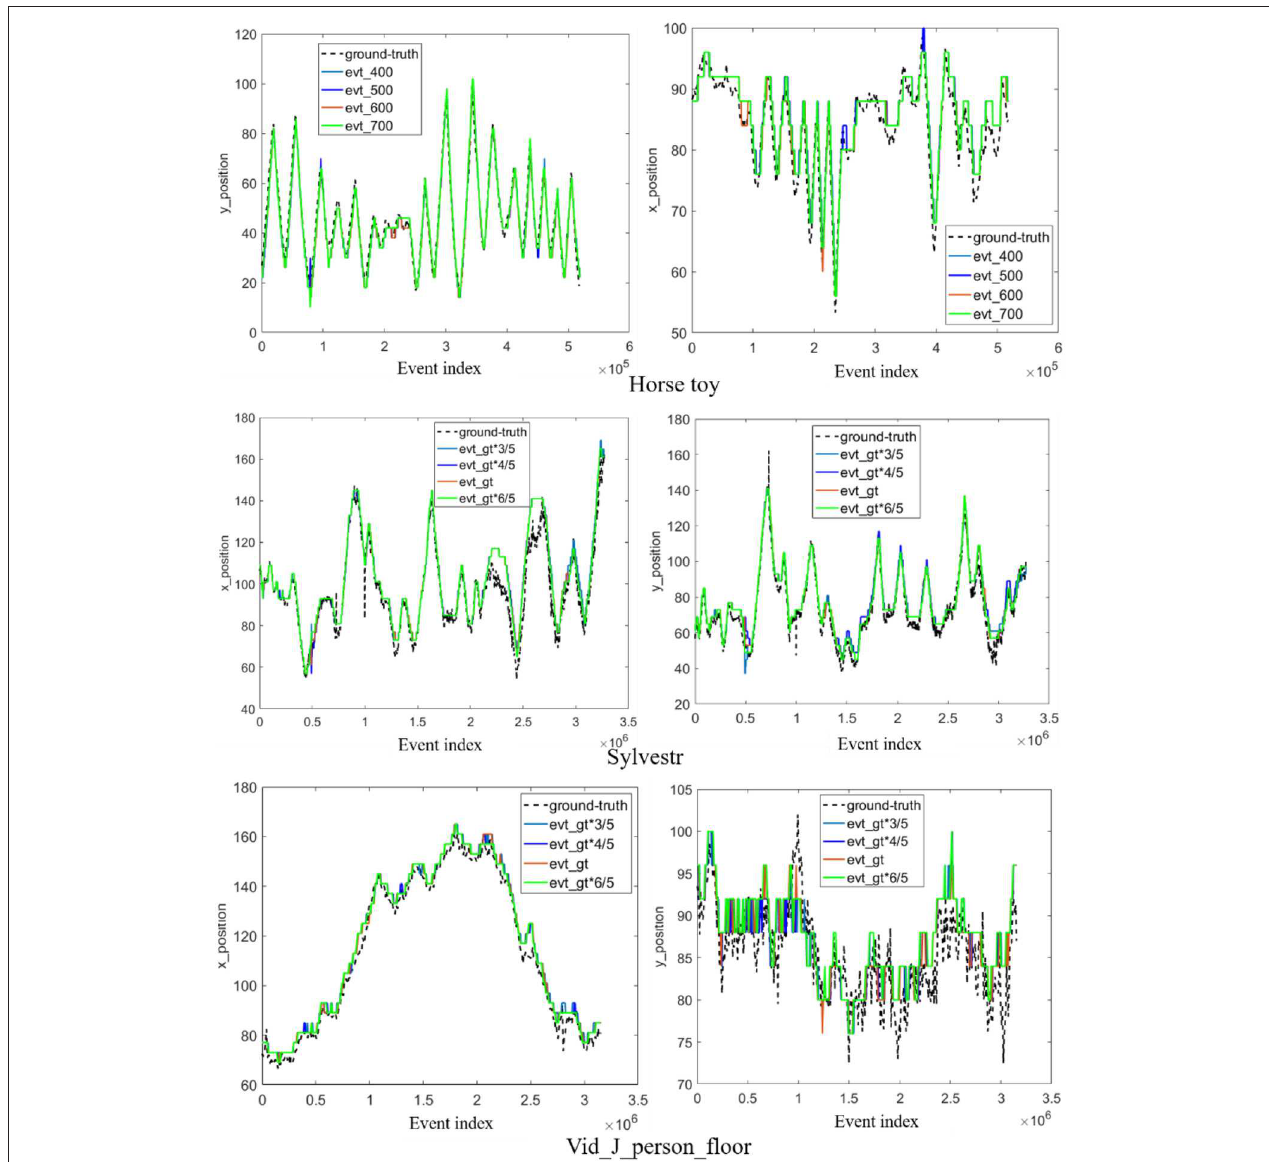
FIGURE 3 | Tracking performance under different event number per time bin on three event-stream recordings (from top to bottom are “Horse toy,” “Sylvestr,” and “Vid_J_person_floor” scenes, respectively). The x (left) and y (right) positions of the center of the tracker over the time are displayed. We use the index of event to represent the time coordinate, and the * mean